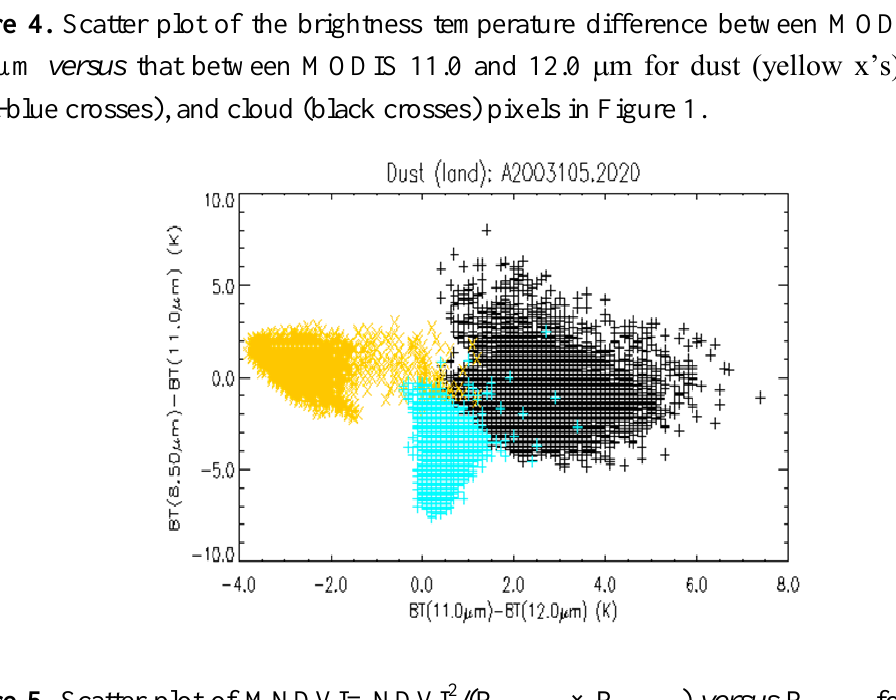
× R ) versus R for clear-sky 0.64µm 0.64µm 1.38  m